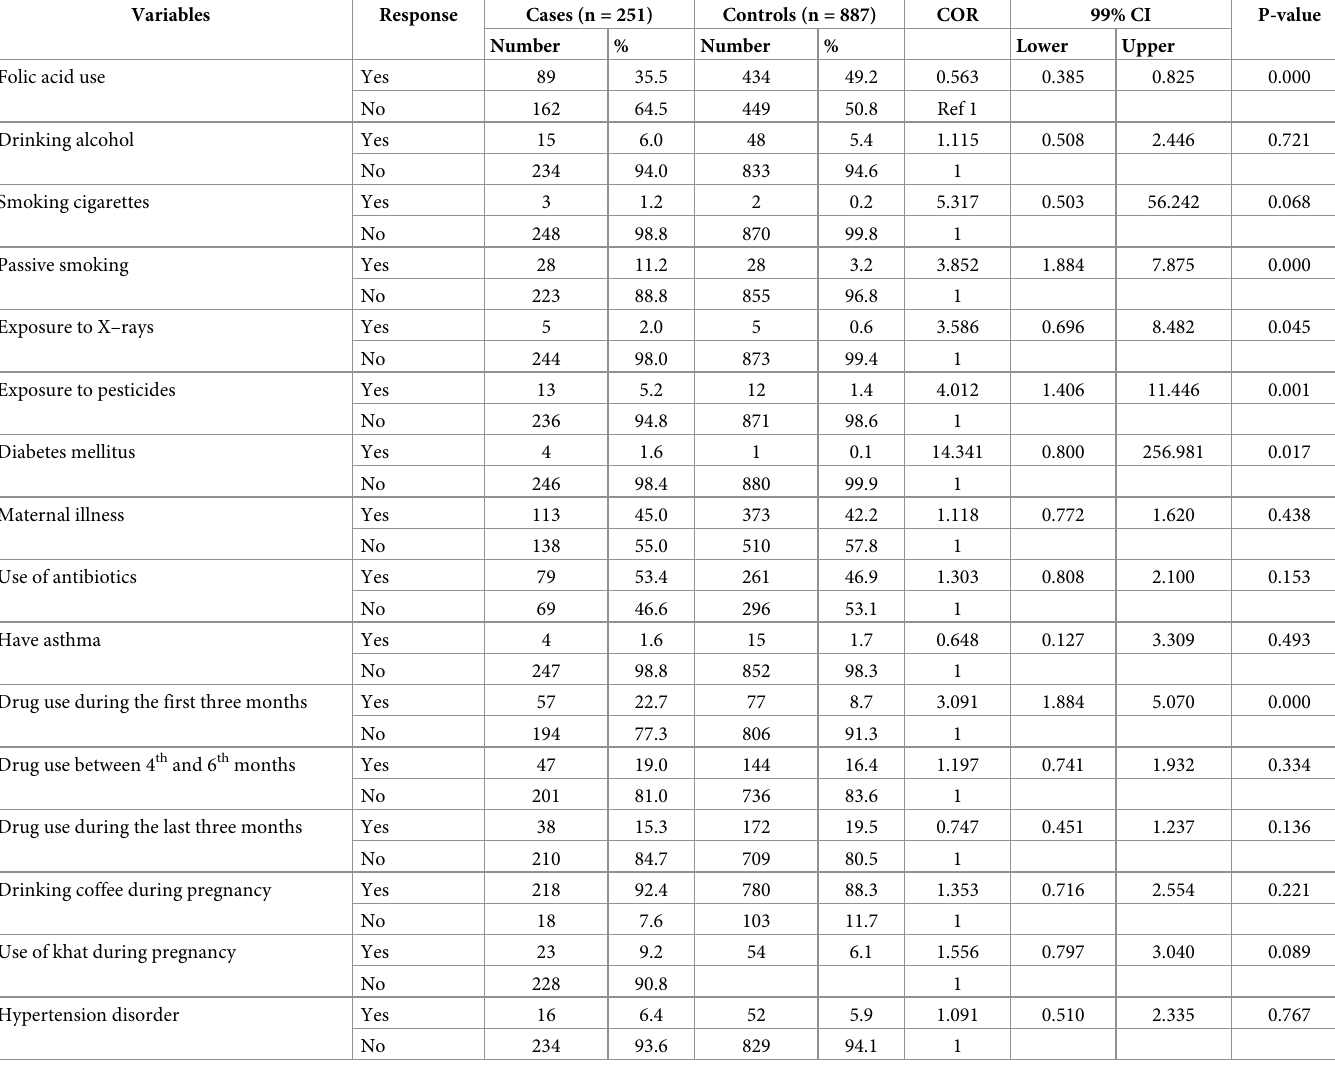
Table 5. Bivariate analysis of environmental, family history, exposure to different chemicals, and maternal illness of the study subjects in southwestern Ethiopia.